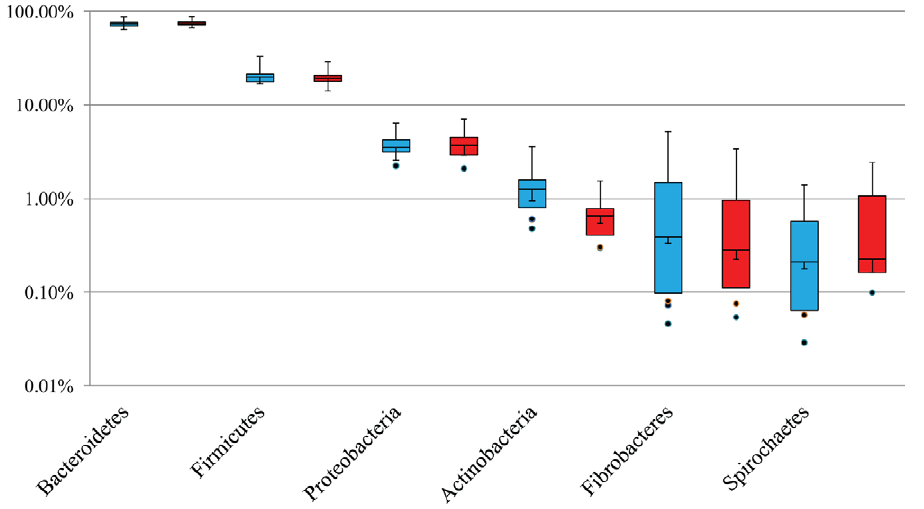
Figure 2. Phylum-level relative composition of the microbiome in the porcine proximal colon. Boxes denote the inter-quartile range between the 1 st and 3 rd quartiles (25 and 75%, respectively, N =11). Blue: detected using MetaPhyler; Red: detected using MG-RAST. Y-axis: log scale.